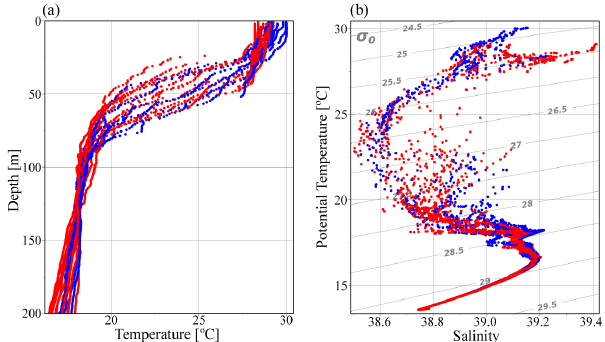
Fig. 5. (a) Vertical profiles of temperature and (b) T–S diagram, for stations in (blue) and out (red) of the patch (see Fig. 3 for sta- tion locations). Figure was made using Ocean Data View (Schlitzer,